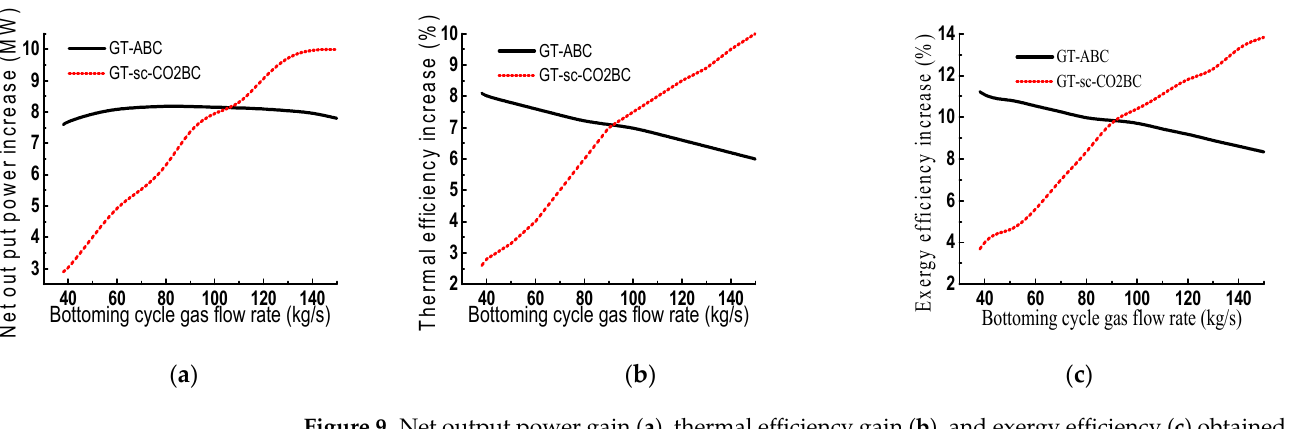
Figure 9. Net output power gain ( a ), thermal efficiency gain ( b ), and exergy efficiency ( c ) obtained with GT-ABC and GT-sc-CO 2 BC compared with ASC versus gas flow rate (bottoming cycle pressure ratio = 3.3 and ambient temperature = 390 kg/s).